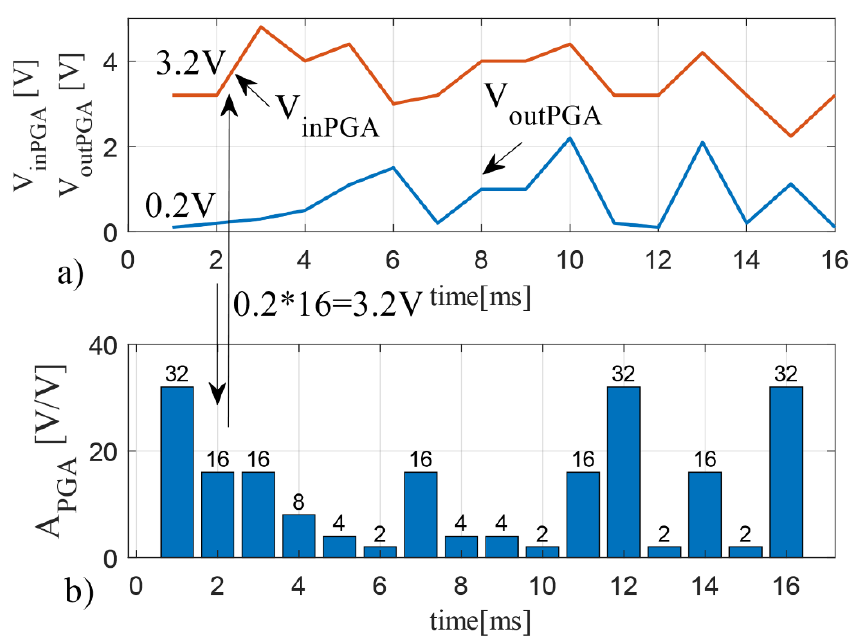
Figure 2. Waveform of ( a ) the input V inPGA output voltage V outPGA from the PGA amplifier connected to the current transducer; ( b ) the gain of the PGA amplifier controlled by the microprocessor system.